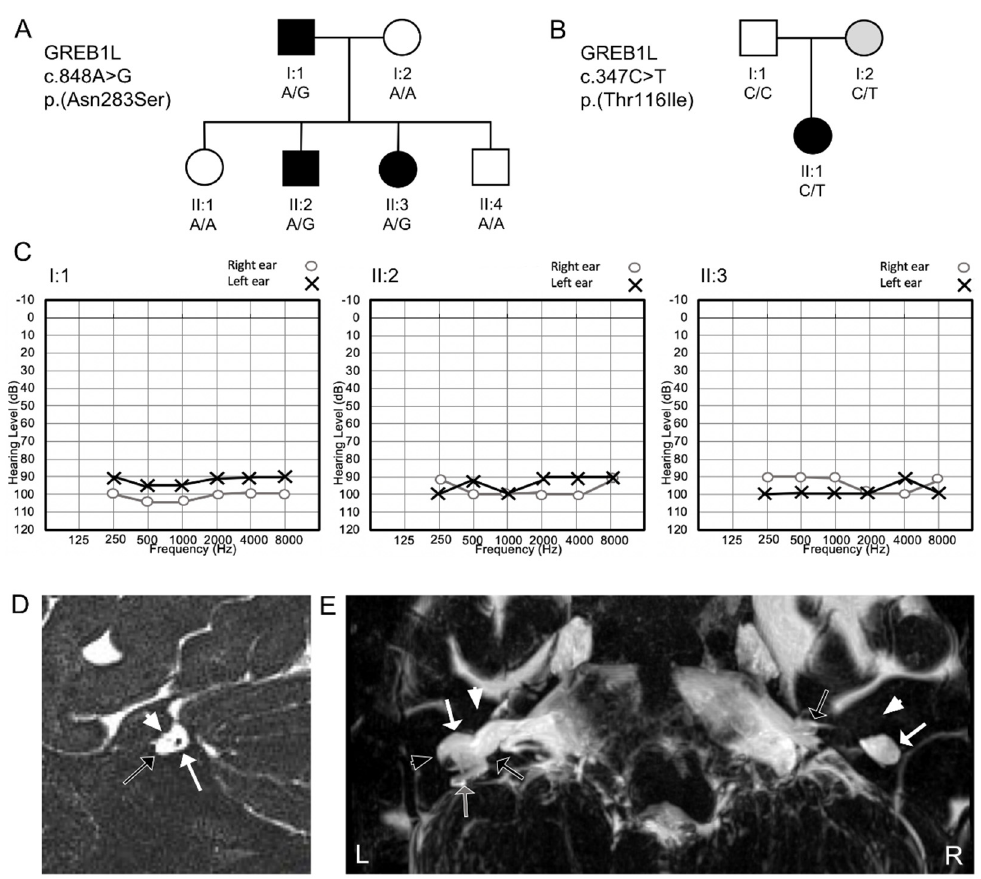
Figure 1. Segregation of the GREB1L missense variants in both families, audiological and imaging data. A / B . Segregation of the p.(Asn283Ser) GREB1L variant in family 1 (4697) ( A ) and p.(Thr116Ile) variant in family 2 (BAIE1) ( B ). Solid black symbols represent a ff ected individuals and clear symbols una ff ected family members. Grey symbols represent una ff ected individuals that are also heterozygous for the variant (reduced penetrance). Females are represented by circles and males by squares. ( C ) Pure-tone audiograms of hearing-impaired family members of family 1 illustrate that each one presents with bilateral profound HI. ( D ) Oblique sagittal T2 sequence across the right internal auditory canal (IAC) of patient II:1 of family 2. The white arrow indicates the vestibular nerve (black dot). The arrowhead indicates a hypoplastic facial nerve (small grey dot). The black arrow indicates the area in the IAC where the cochlear nerve is expected but not observed. ( E ) Maximum intensity projection of a heavily T2 weighted sequence to the inner ear of the a ff ected individual (II:1) of family 2. Bilateral cochlear aplasia and dysplasia of the vestibular system is visualized. The white arrowhead indicates the area where the cochlea is expected but not seen (bilaterally). The white arrow indicates a dysplastic cystic dilated vestibule on each side. The black arrow indicates a left narrow IAC and the right broad IAC with wide communication between the fundus of the IAC and the vestibule. The black arrowhead indicates a right dilated lateral semicircular canal. The grey arrow indicates a right rudimentary posterior semicircular canal. L, Left; R, right.